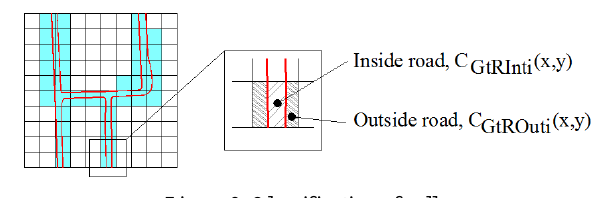
Figure 6. Classification of